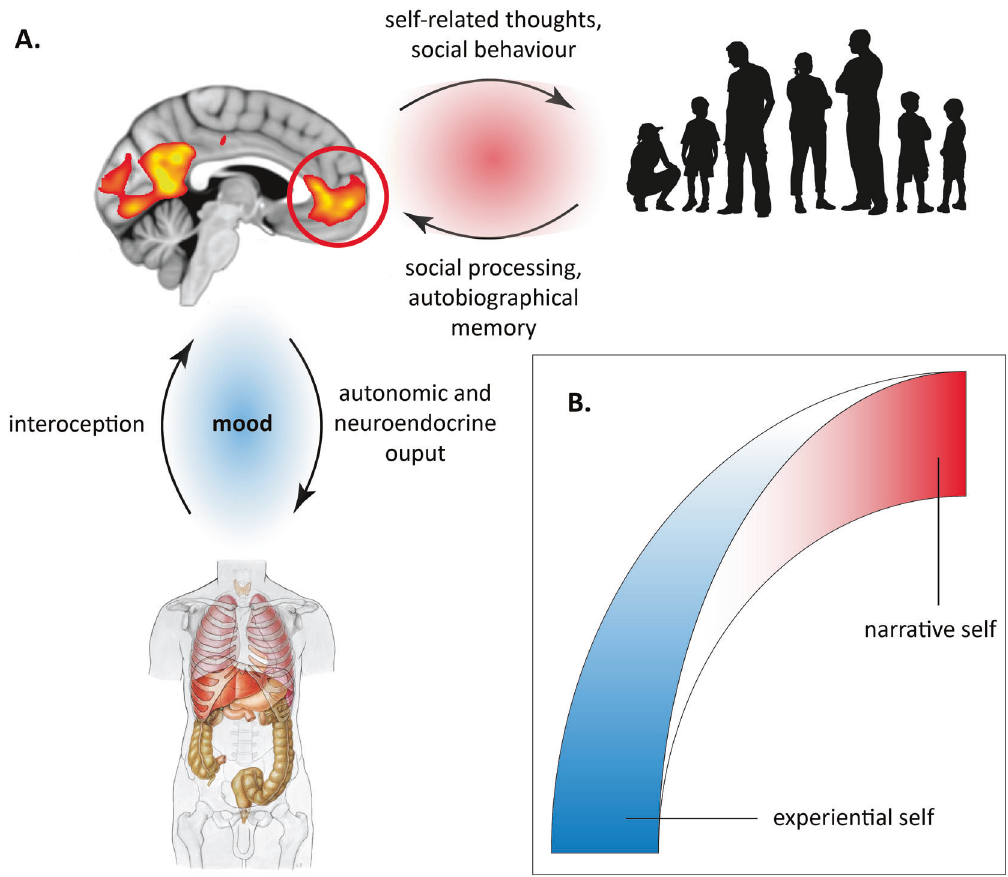
Fig. 1 The self axis. The self is a dynamical entity that emerges from reciprocal brain relationships with the body and social environment ( A ). The self exists on a continuum from a subjective, pre-re fl ective “ experiential ” self to an objective, cognitively represented “ narrative self ” : forming what we term the self axis ( B ). The medial prefrontal cortex (MPFC; circled), a part of the default mode network, has a key coordinating role, intermediating between apprehension of the social environment and somatic processes. Mood emerges from somatic processes, under top-down in fl uence of the MPFC. It forms a fundamental part of the experiential aspect of the self, both in fl uencing and being in fl uenced by the narrative